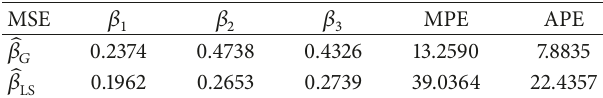
Table 3: Simulation results of estimation and prediction for Exper- iment